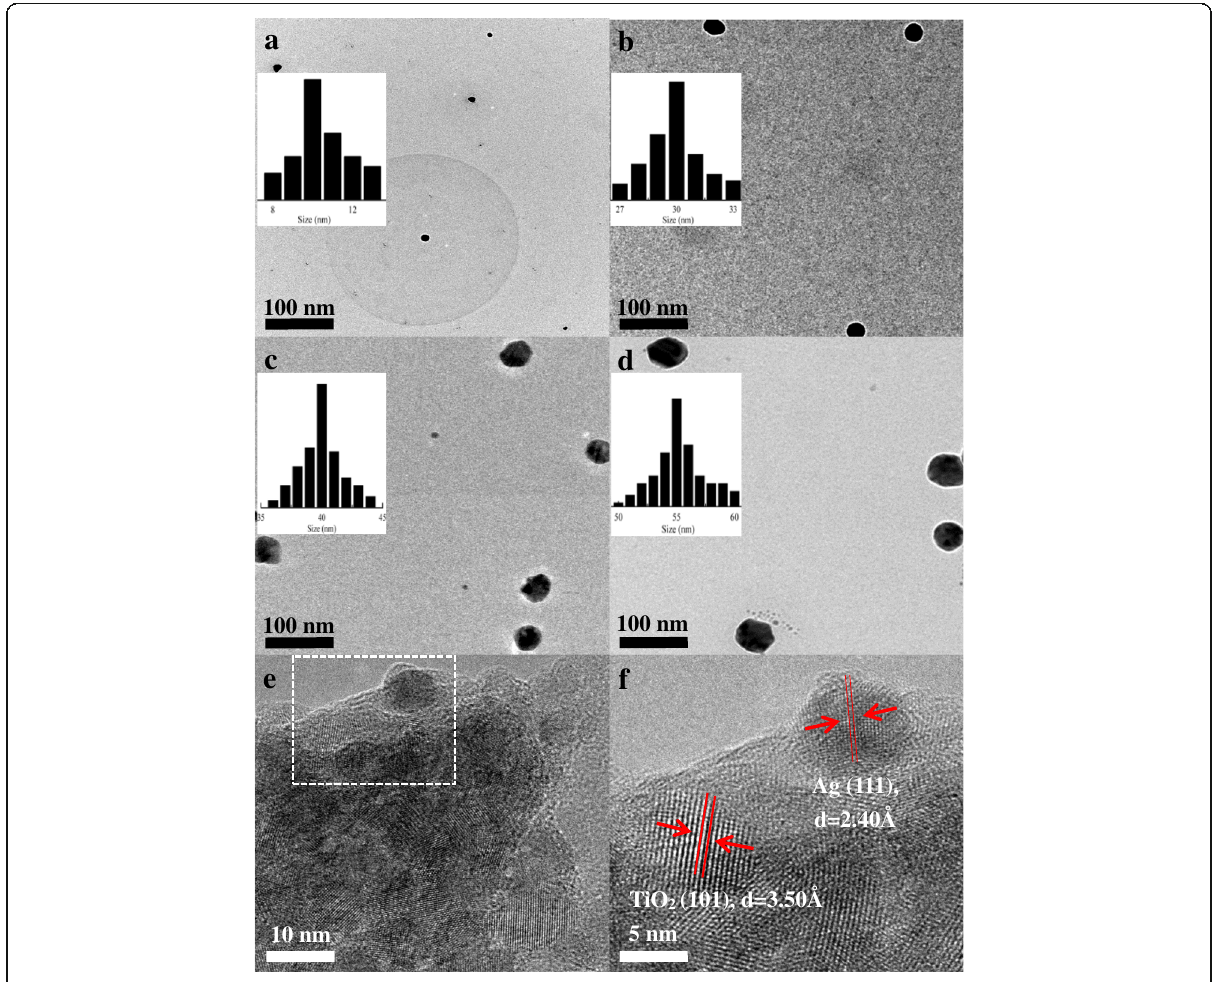
Fig. 3 HRTEM images and size distribution results of a 10-nm Ag NPs, b 30-nm Ag NPs, c 40-nm Ag NPs, and d 55-nm Ag NPs; HRTEM images of e Ag/TiO 2 composite compact film and f enlarged image from the dotted area of